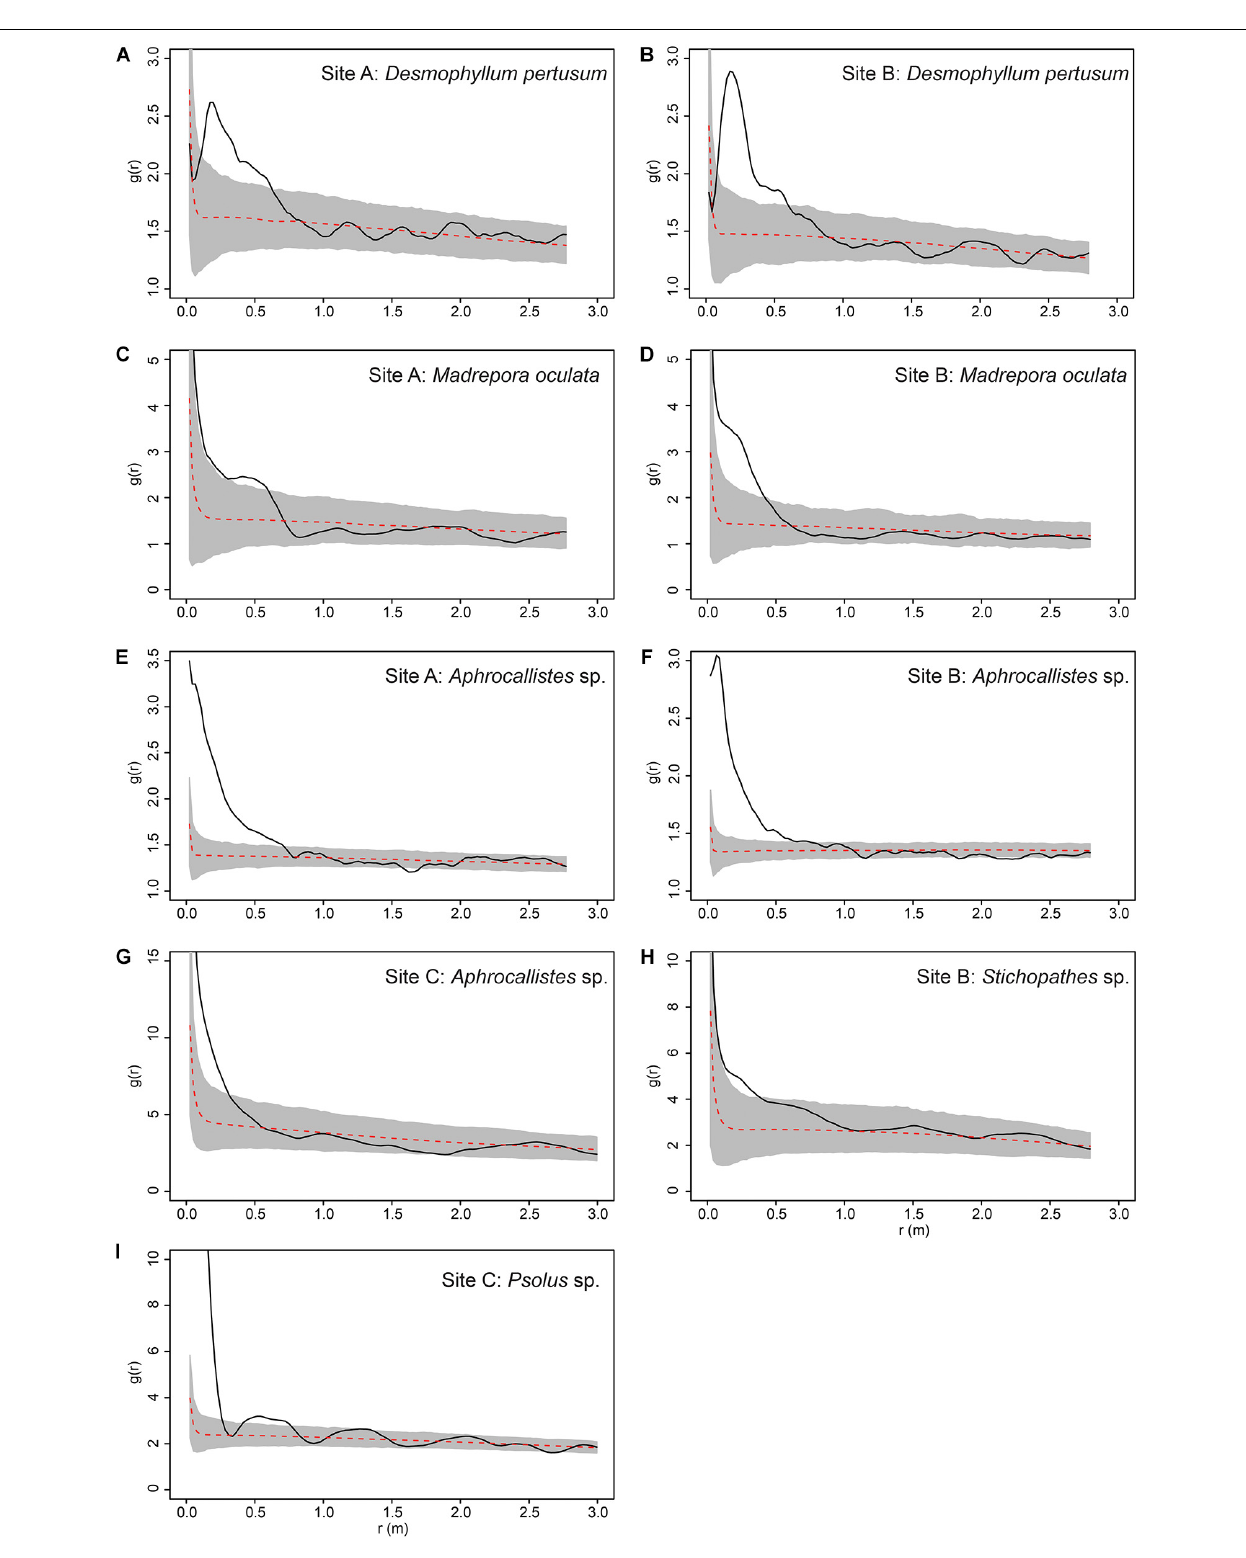
FIGURE 10 | Pair Correlation Function results for specific species at specific study sites. Grey area represents the simulation envelope and the dashed red line indicates the mean of the inhomogeneous null model. (A) Desmophyllum pertusum at Site A. (B) D. pertusum at Site B. (C) Madrepora oculata at Site A. (D) M. oculata at Site B. (E) Aphrocallistes sp. at Site A. (F) Aphrocallistes sp. at Site B. (G) Aphrocallistes sp. at Site C. (H) Stichopathes sp. at Site B. (I) Psolus sp. at Site